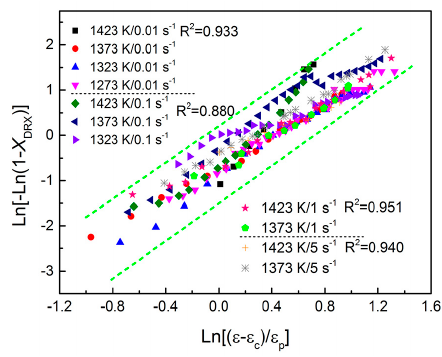
Materials 2017 , 10 , 318 10 of 18 Based on Equation (23), the DRX kinetic curves of 70MnSiCrMo carbide-free bainitic steel at different temperatures and strain rates are shown in Figure 11. It is obvious that the DRX volume fraction increases toward 1 (100% DRX) with increasing strain in terms of the S -shape. Increasing temperature or decreasing strain rate can speed up the DRX process because the migration rate of dislocations and grain boundaries becomes higher, and thus results in a remarkable increment in the Figure 10. Relationship between ln[ − ln(1 − X DRX )] and ln[( ε − ε c )/ ε p ] under different working conditions. Figure 10. Relationship between ln[ − ln(1 − X − ε c )/ ε p ] under different working conditions. DRX )] and ln[( ε amount of DRX volume fraction at the same strain.